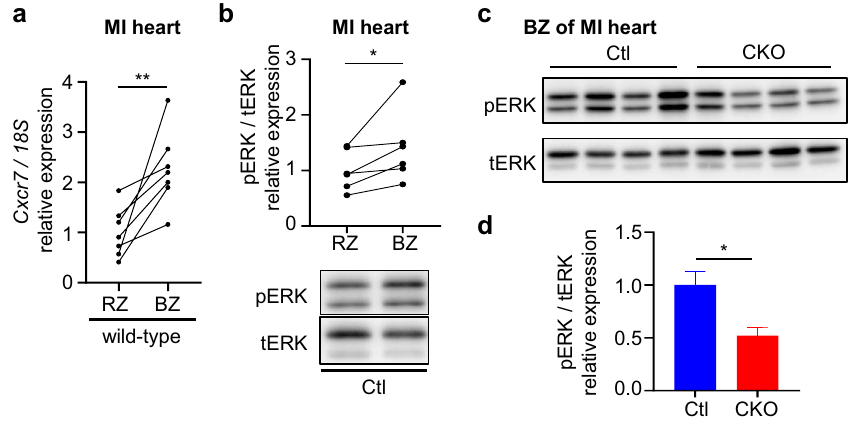
Figure 4. Cxcr7 is upregulated concomitantly with ERK activation in the border zone of myocardial infarction. ( a ) Cxcr7 mRNA levels in infarcted murine hearts. The heart tissue was dissected into two portions: a remote zone (RZ) and a border zone (BZ). Replicate samples were derived from heart tissues of wild-type mice (n = 7). Data are shown as paired data points. Significance was calculated by a paired t -test; ** P < 0.01. ( b ) Immunoblot analysis of pERK and tERK in the RZ and BZ of infarcted heart. The bar chart shows the mean pERK-to-tERK ratio normalized to the value in the RZ. Samples were from infarcted heart tissues of Ctl mice (n = 6). Data are shown as paired data points. Significance was calculated by a paired t -test. * P < 0.05. ( c ) Immunoblot analysis of pERK and tERK in the BZ in infarcted hearts of Ctl and CKO mice. ( d ) Quantitative data of the results in Fig. 4c. Ctl, n = 6; CKO, n = 4. Data are shown as the mean ± SEM. Significance was calculated by an unpaired t -test. * P < 0.05.